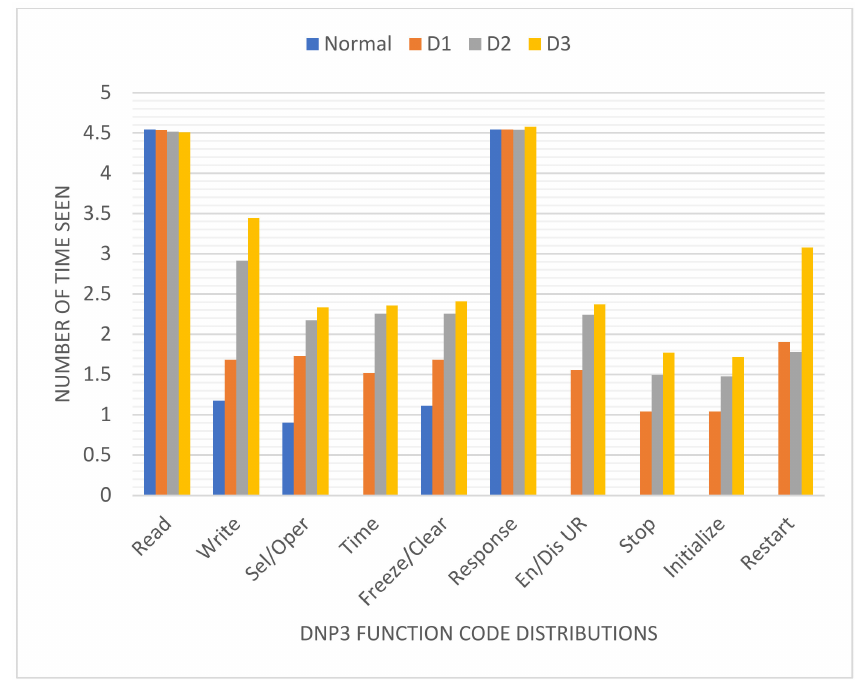
Figure 12. Function codes distributions of Normal, D1, D2,